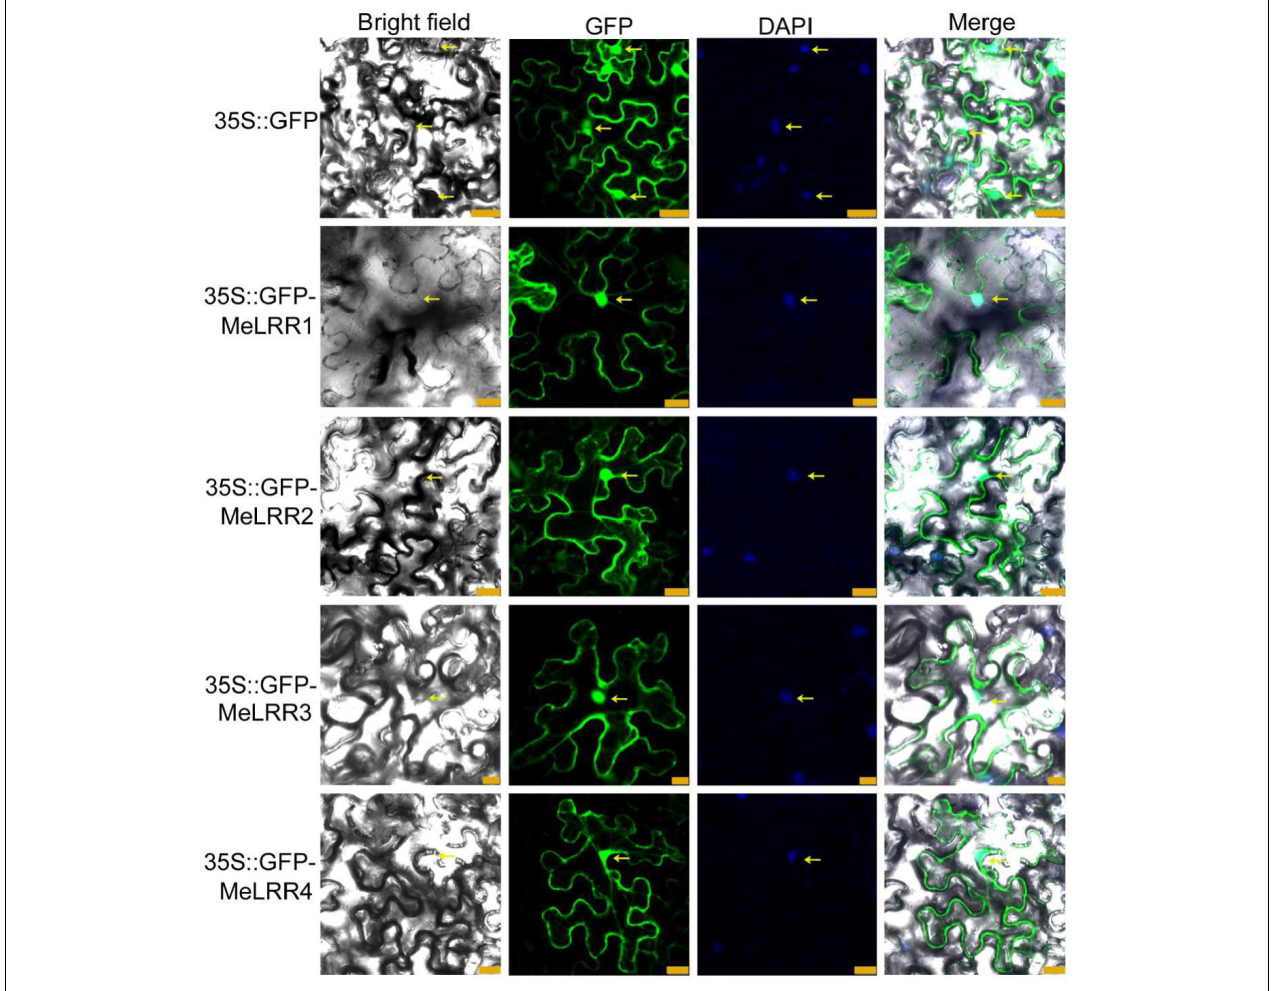
FIGURE 1 | Subcellular localization of MeLRR proteins in N. benthamiana leaves. Transient expression of Agrobacterium GV3101 with 35S:GFP and 35S:GFP-MeLRRs plasmids in N. benthamiana leaves. After 2 dpi, the fluorescence was scanned by a Leica confocal microscopy system (Leica TCS SP8, Solms, Germany) with an excitation wavelength of 488 nm and a 505–530 nm bandpass emission filter. The empty vector 35S:GFP was used as a control. Nuclei were stained using DAPI (4’,6-diamidino-2-phenylindole). Scale bar = 25 µ